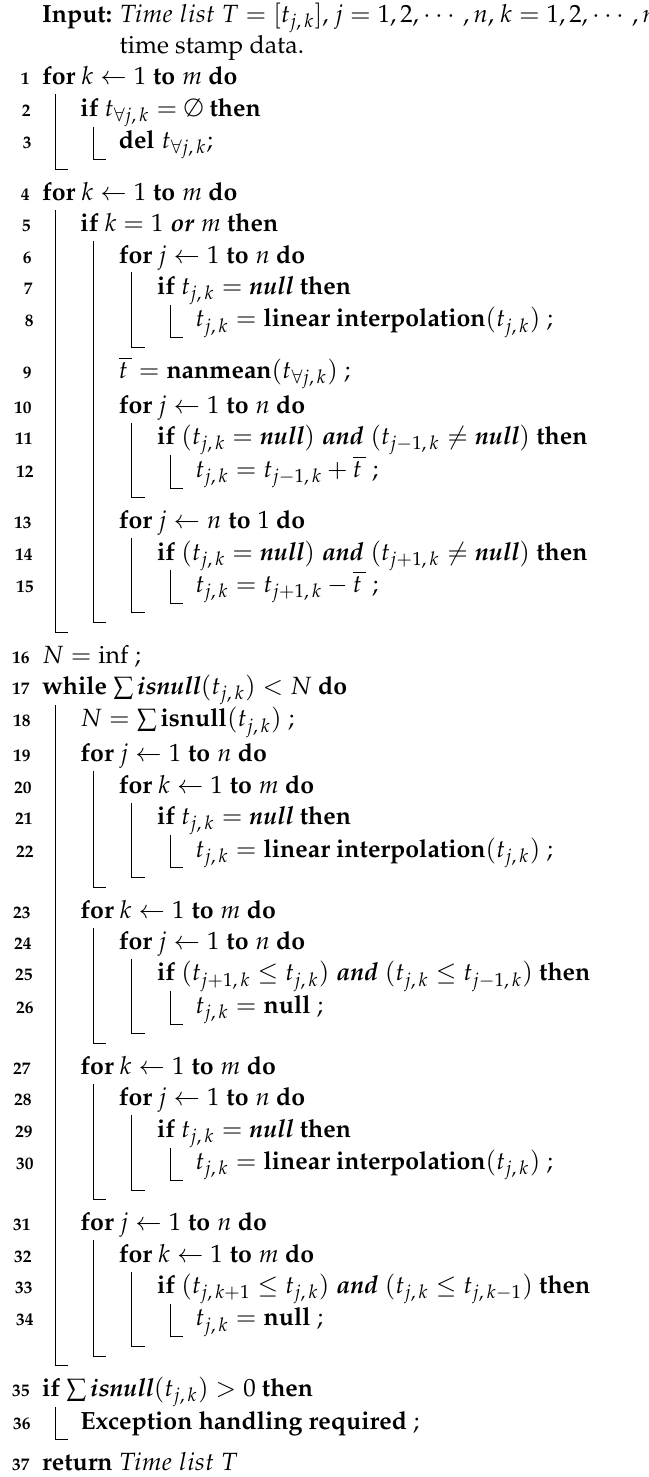
Algorithm 4: Interpolation